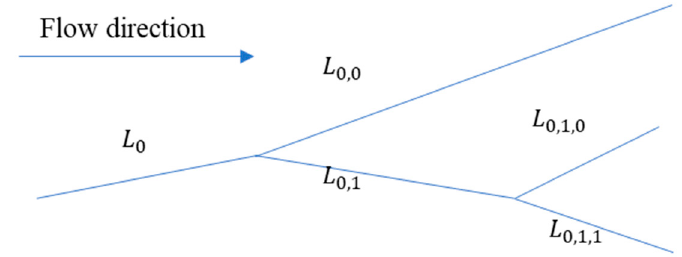
Figure 3. Example fracture network showing bifurcation of an initial crack leg 𝐿 (cid:2868) into subsequent crack crack legs.